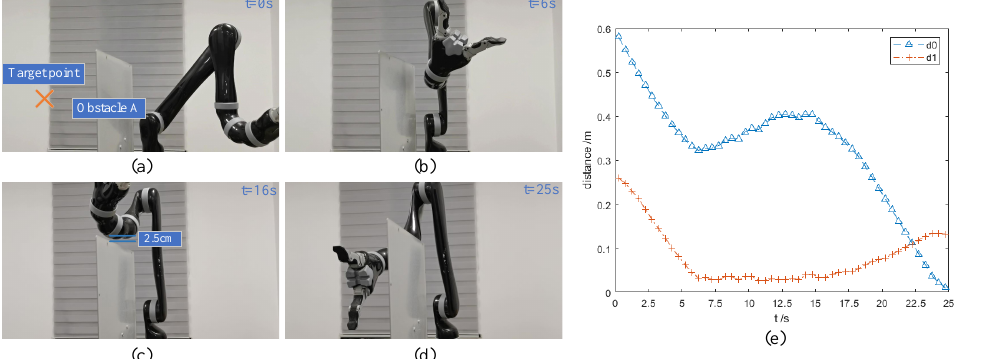
Figure 11. Experiments E: actual experiments. ( a – d ) The running process of the robot arm when it is using the IVPF algorithm. ( e ) The distance between the robot arm and the target point and the obstacle in the